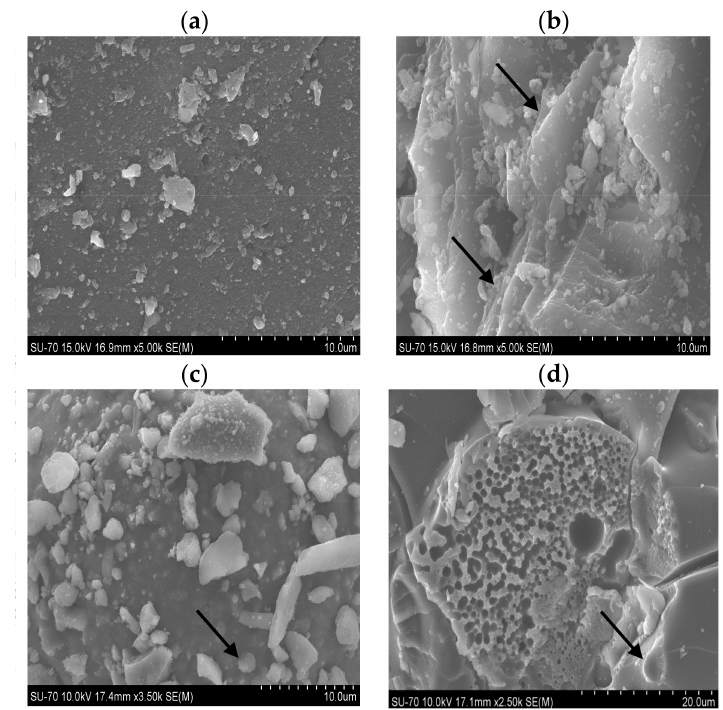
Figure 4. Scanning electron micrographs of SC ( a ); SIL indicating the black arrows a more porous and irregular surface ( b ) and CBE-SC ( c ) and CBE-SIL ( d ) indicating the black arrows possibly the presence of lipase due to its characteristic rounded